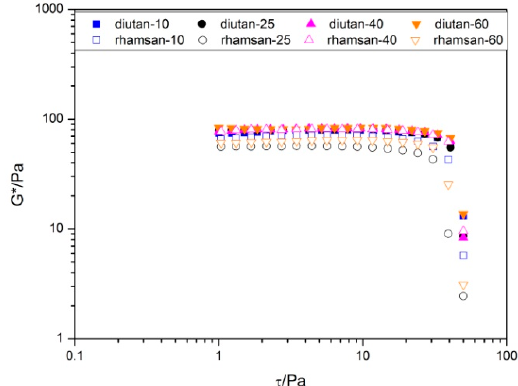
Figure 2. Comparison of the temperature effect on the linear viscoelastic region of the diutan gum aqueous solutions and rhamsan gum aqueous solutions.